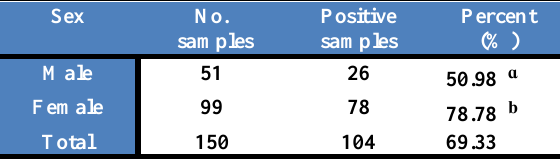
Table, 2: Percentage of positive LSD samples according to gender by PCR in male